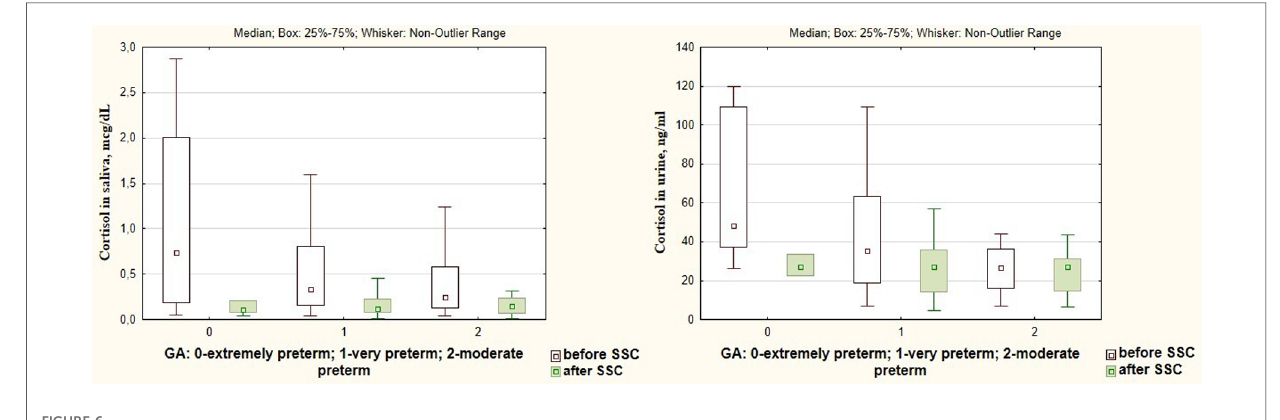
FIGURE 6 Cortisol levels in saliva and urine before and after SSC in preterm infants of different gestational age.